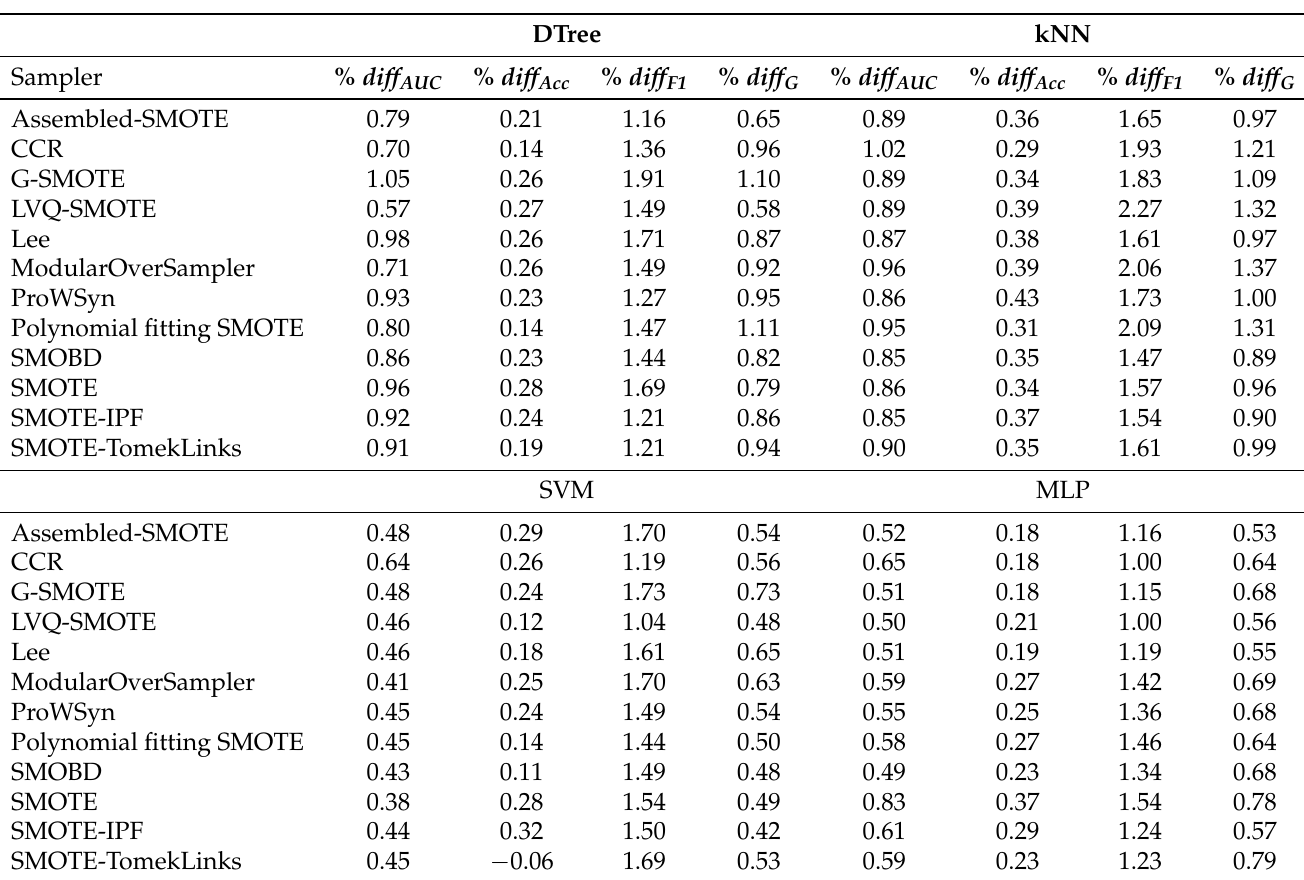
Table A1. Mean of the relative differences of the DOB-SCV and SCV per oversampler on the KEEL data sets.